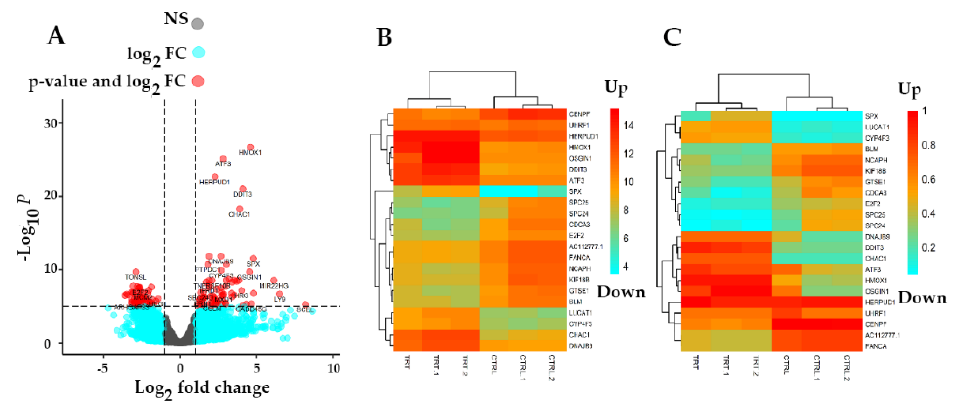
Figure 3. Normalization of raw read counts and Differential Expression Analysis (DEA). The volcano plot ( A ) of non-significant DEGs (colored in dark gray), significant DEGs (padj < 0.01) (colored in light blue), and up/downregulated genes (Colored in red). The x-axis represents the log2 FC, while the y-axis represents the statistical significance for each gene based on − log10 ( p value). Heatmap of top 22 up/downregulated genes associated with non-normalized counts ( B ). Heatmap of top 22 up/downregulated DEGs associated with normalized counts ( C ). From the heatmap (downregulated genes are colored in light blue and upregulated genes are colored in orange in both plots). NS: non-significant; FC: fold change. Table 2. The list of top 10 up/downregulated Differentially Expressed Genes (DEGs) based on RNA- seq data analysis. The DEGs (padj < 0.01) between control and treatment groups are shown with top 10 upregulated genes (padj < 0.01, log2 FC > 2), and top 10 downregulated genes (padj < 0.01, log2 FC < − 2). Padj: adjusted p